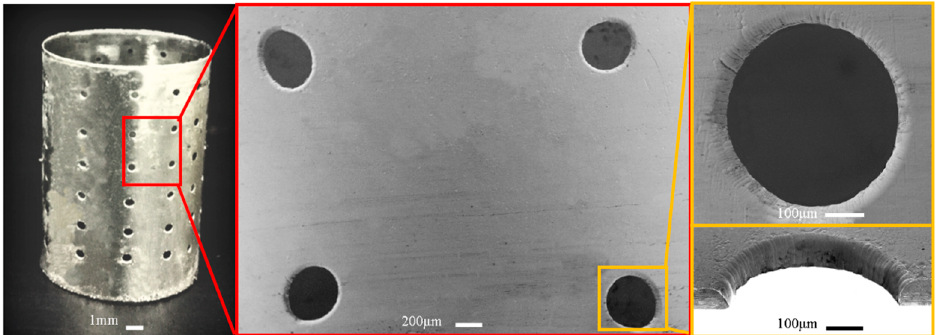
with the outside surface of the SS pipe.